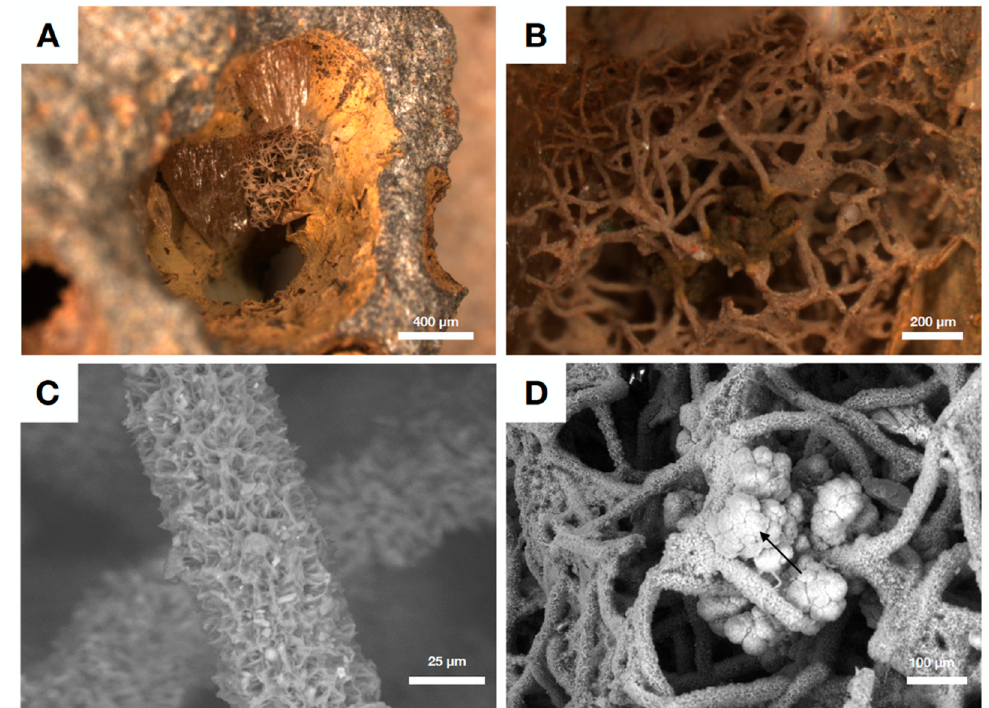
Figure 6. Stereo (A–B) and Scanning Electron micrographs (C–D) of clay mineralized fungal biofilms from Koko seamount, sample 1206-4R-2. ( A ) Vesicle containing clay encrusted mycelia that branch and diverge. Scale bar is 400 μ m. ( B ) Close-up of pristine mycelia network preserved in a rust-colored clay. Scale bar is 200 μ m. ( C ) Close-up of evenly clay encrusted fungal hyphae. Scale bar is 24 μ m. ( D ) Fungal mycelia with embedded cauliflower-like microstromatolites of Frutexites -type